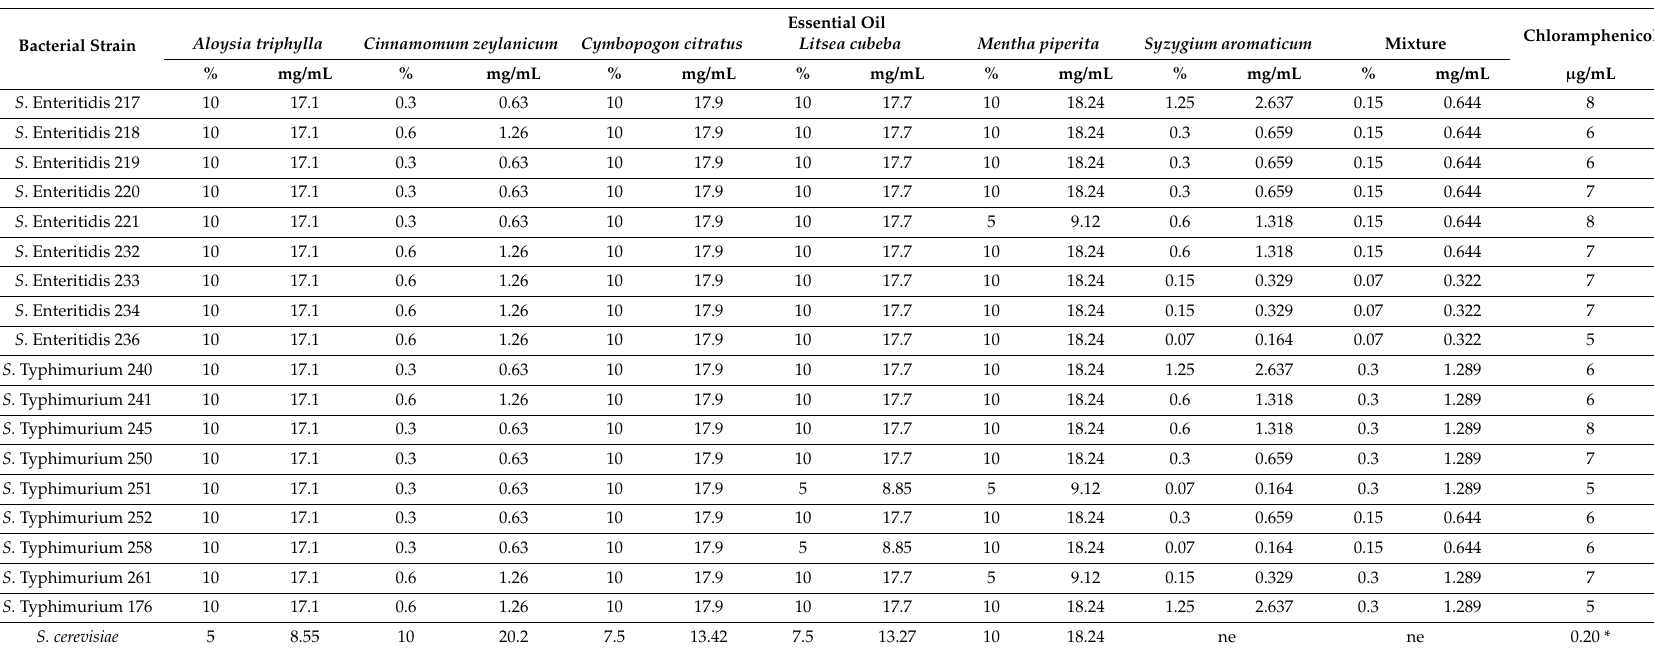
Table 3. Minimum inhibitory concentration (MIC) values of tested EOs and the mixture, expressed as both percentage and mg/mL, against selected Salmonella Enteritidis, Salmonella Typhimurium and Saccharomyces cerevisiae